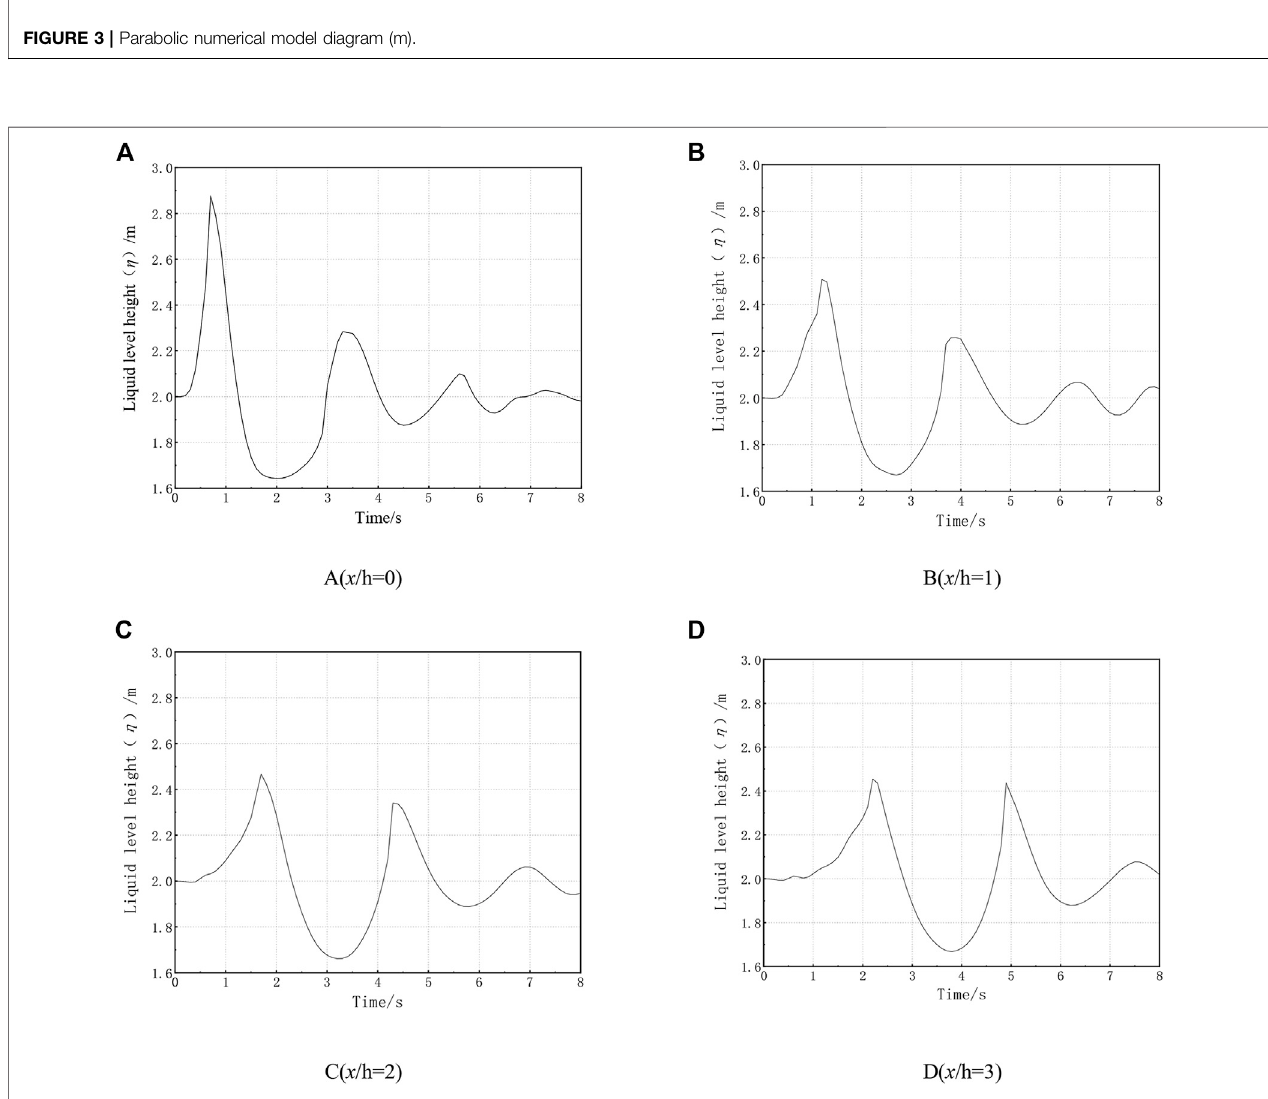
FIGURE 4 | Free surface height time-history at the featured points (A – H)